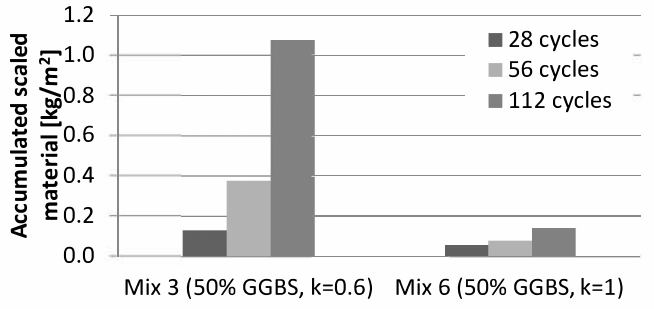
Figure 18. Mean values of the accumulated mass of scaled material per area of freezing surface after 28, 56 and 112 cycles for concrete with 50% GGBS and di ff erent e ffi ciency